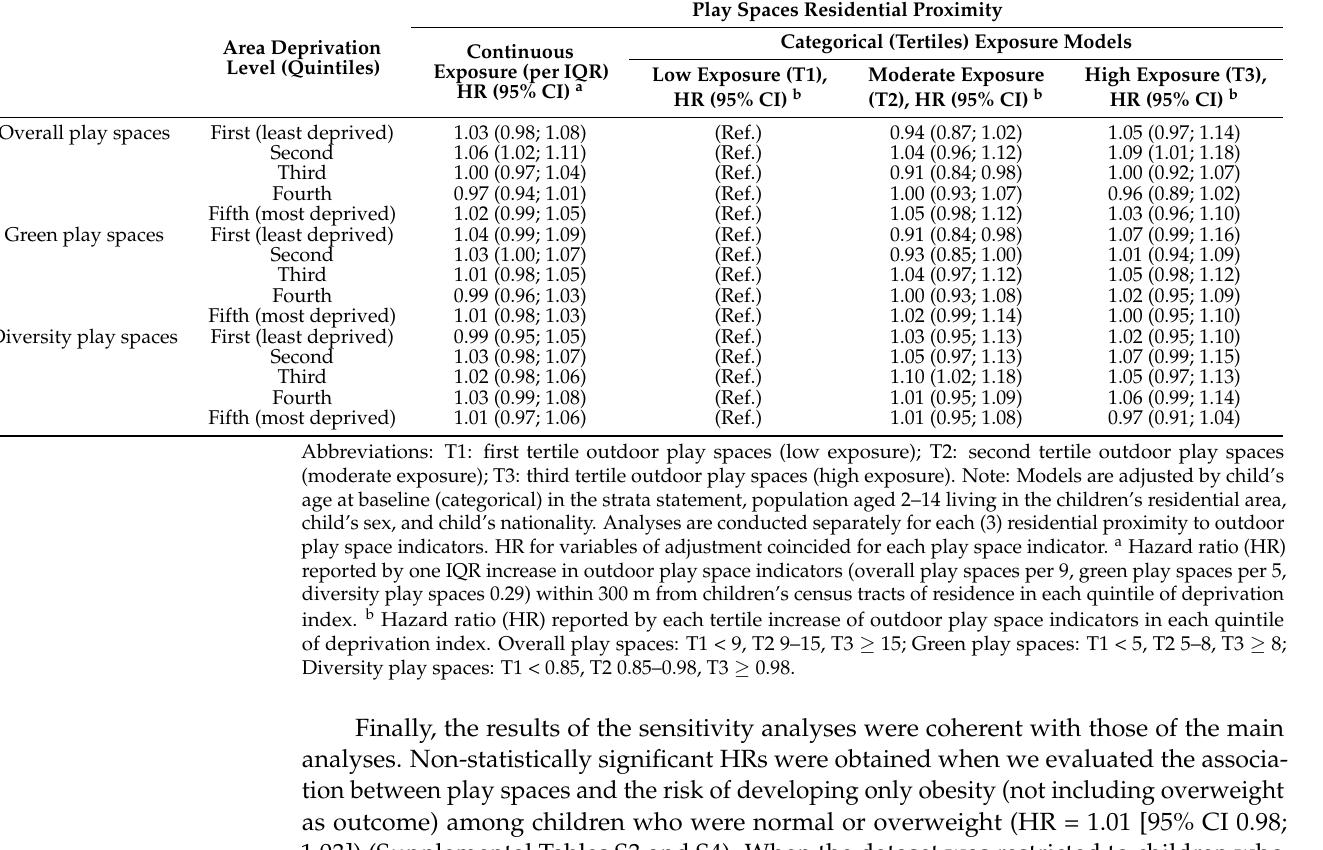
Table 4. Adjusted associations between residential proximity to play spaces (continuous and in tertiles) and development of childhood overweight or obesity by area SES (quintiles of deprivation) (N =